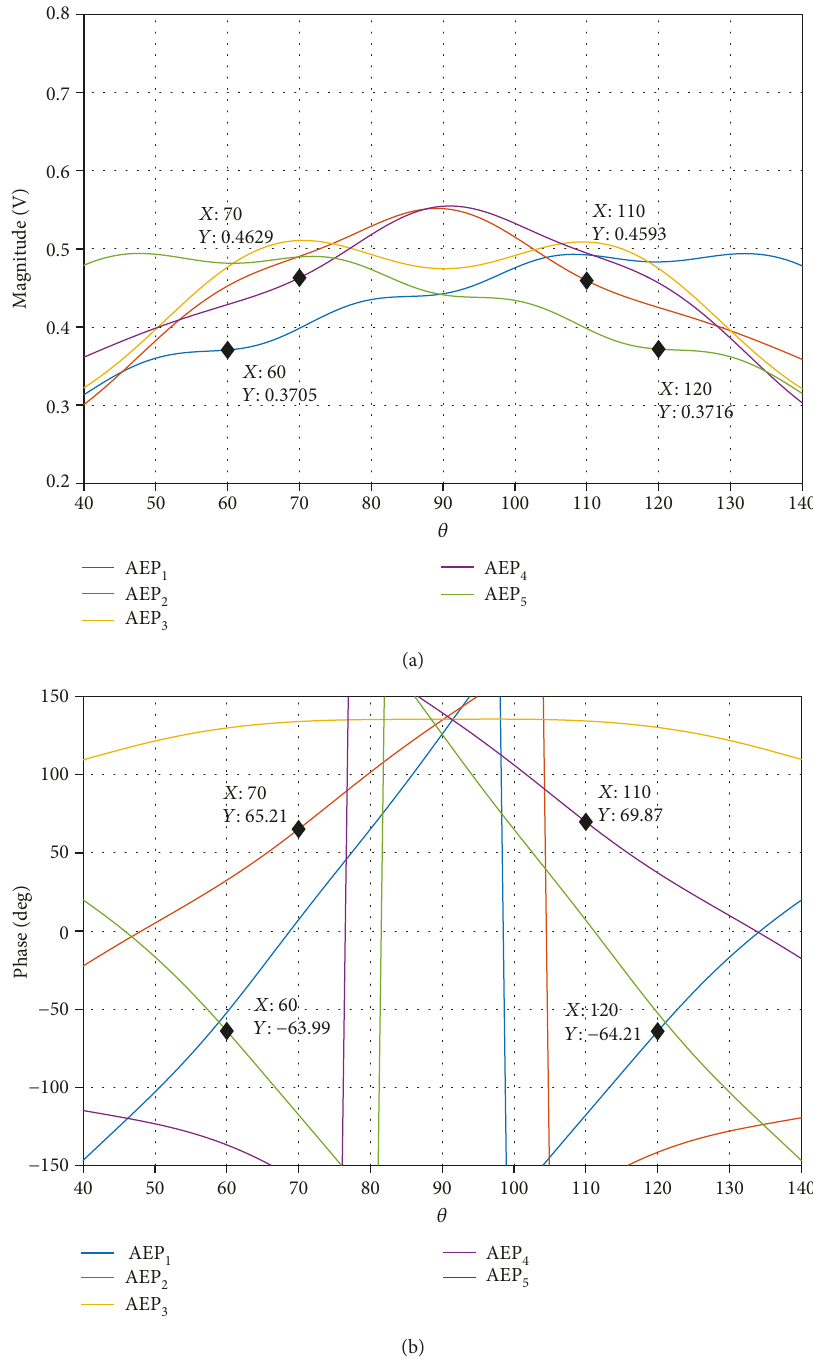
Figure 12: Active element pattern (H-plane) for an array of 5 λ /2 dipole antennas spaced λ /2 with coaxial cables. (a) Magnitude. (b)